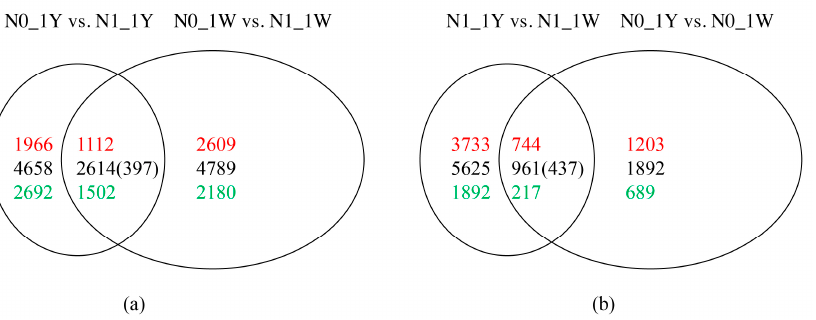
Figure 3. Venn diagram of the DEGs derived from different pairwise comparisons. The differentia-